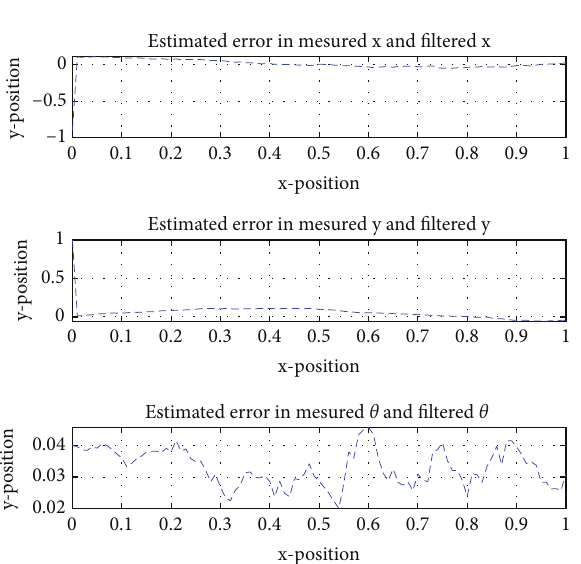
Figure 14: The state of the WMR with the PF (one landmark-non- Gaussian noise).